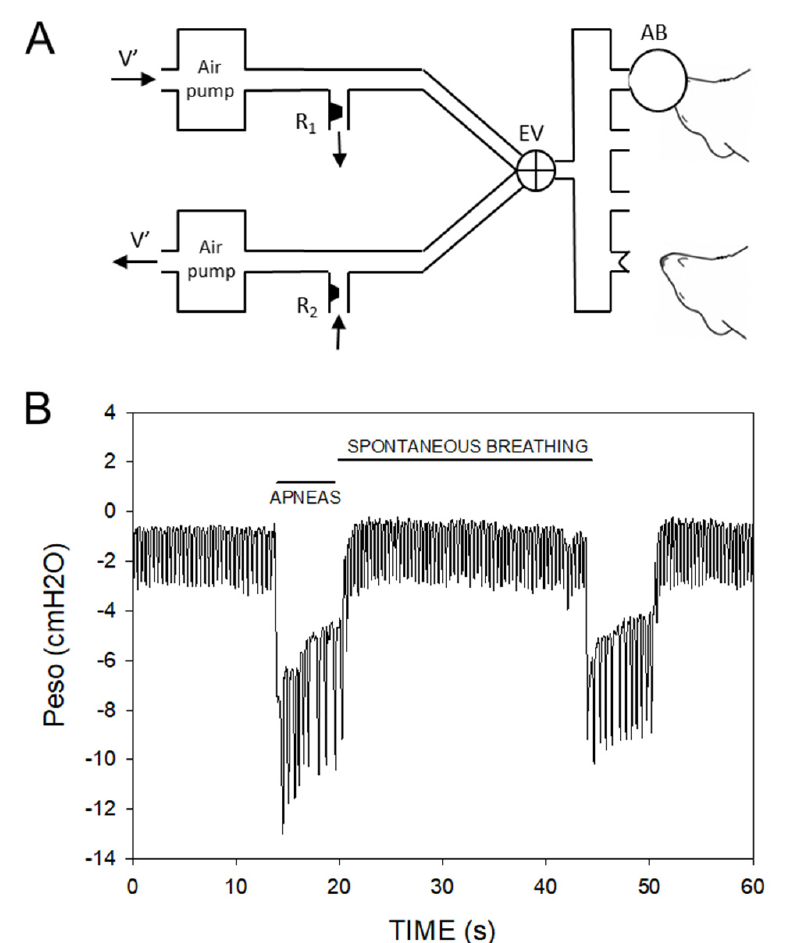
Figure 2. Model to apply airway obstruction mimicking sleep apnea. ( A ) Diagram of the system. V ′ : flow generated by both air pumps (reversed directions). R1 and R2: resistors. EV: three-way electrovalve. The resistance of R1 was greater than that of R2 to generate higher positive (30 cmH 2 O) than negative ( − 5 cmH 2 O) pressure. Four airbags were connected to the source of alternant pressure. For the sake of simplicity and illustration, the figure shows only two airbags in place: one inflated (30 cmH 2 O) to apply airway obstruction to the mouse (top) and the other one deflated ( − 5 cmH 2 O) to allow the mouse to breathe spontaneously. ( B ) Example of esophageal pressure (Peso) recording in one mouse during application of two of apneas (6 s each at a rate of 120/h). Reprinted with permission from Ref. [55]. 2011. Elsevier .